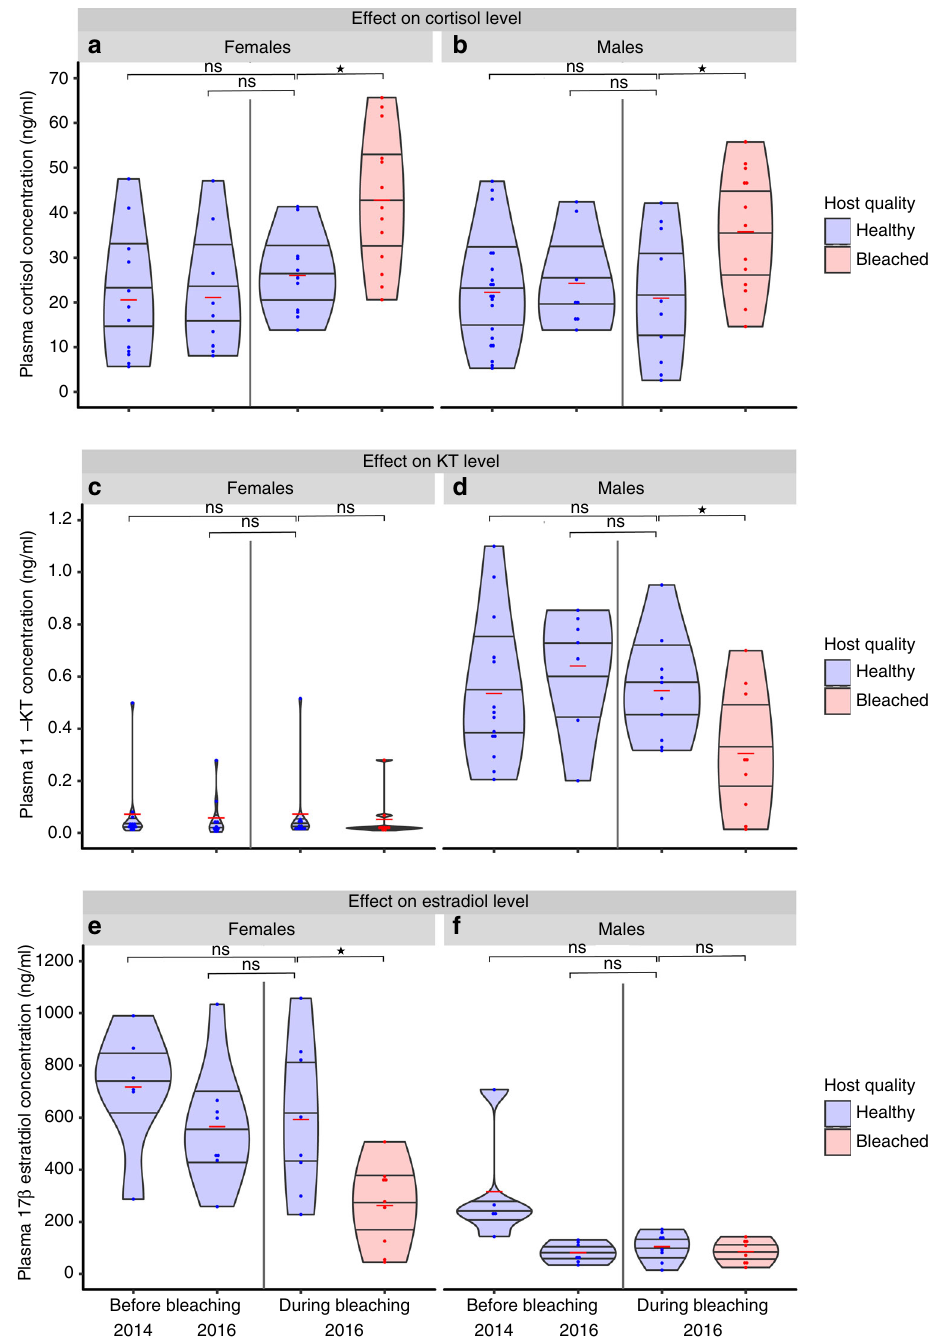
Fig. 3 Stress and reproductive hormones before and during bleaching events. Effect of exposure to warming-induced anemone bleaching ( red violin plots ) on wild, free-living adult anemone fi sh plasma hormone concentrations compared with those from adults exposed to unbleached hosts ( blue violin plots ) between three periods: twice before (2014 n = 12/20; 2016 n = 9/8 for females/males, respectively) and once during the bleaching event (unbleached n = 11/10; bleached n = 13/13 for females/males, respectively). Hormonal measures were taken from an additional 39 anemone fi sh pairs that were not monitored for spawning every 2 days. a Female cortisol (Linear mixed model (LMM) F 3,41 = 7.309, P < 0.001). b Male cortisol (LMM F 3,47 = 3.464, P = 0.023). c Female 11-KT (LMM F 3,38 = 0.077, P = 0.972). d Male 11-KT (LMM F 3,36 = 4.460, P = 0.010). e Female 17 β -estradiol (LMM F 2,27 = 7.840, P = 0.001). f Male 17 β -estradiol (LMM F 2,23 = 2.986, P = 0.052). Violin plots show the full distribution of the data with the inner part showing all sample points ( blue dots ), the median ( red line ), and the interquartile range overlaid by the kernel density estimation. Non-signi fi cance is denoted by “ ns ” and statistical signi fi cance is denoted by * P <